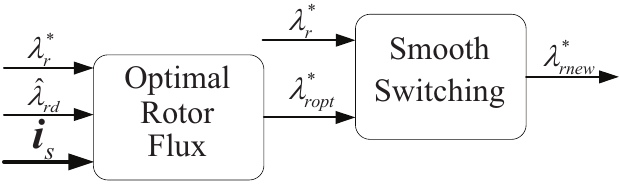
Figure 3. Block diagram of rotor flux smooth switching strategy.